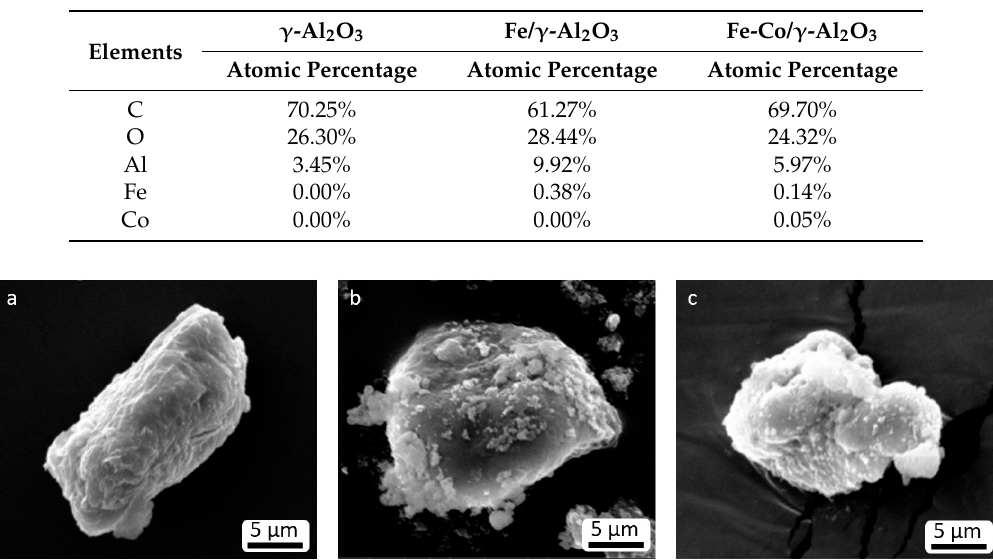
γ -Al γ -Al 2 O 3 ; ( b ) Fe/ 2 O 3 ; ( c ) Fe-Co/ 2 O 3